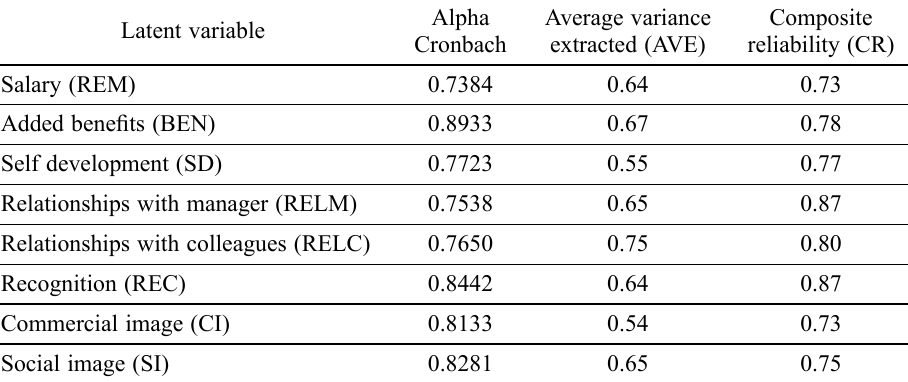
Table 1. Reliability analysis of measurement